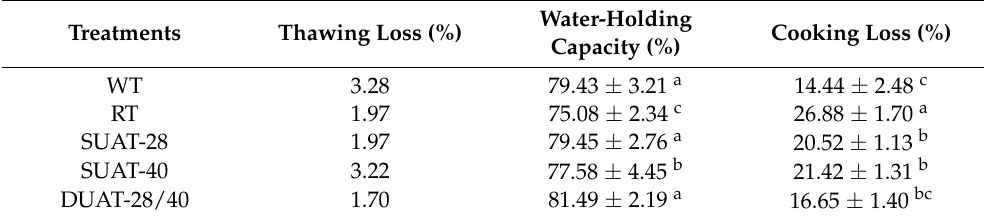
Table 1. Differences in thawing loss, water-holding capacity, and cooking loss of large yellow croaker under different thawing